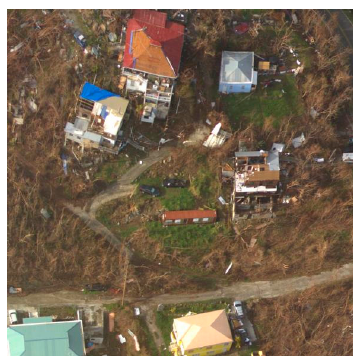
Figure 2. Post-disaster scene map of Hurricane Irma. Show the details in the satellite image because the large size of original remote sensing satellite image.